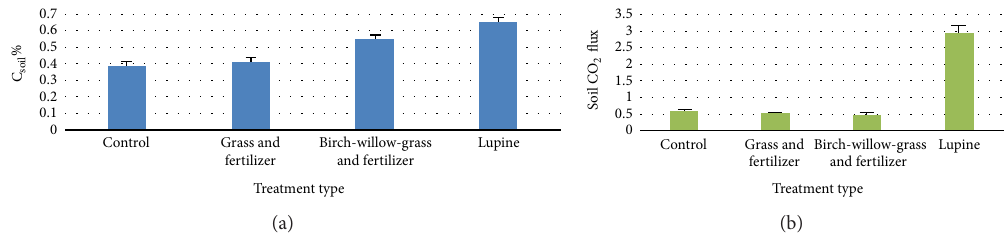
Figure 4: Summary results. (a) Mean soil carbon content for all samples (A and B layers combined shown plus one standard error) for all four treatments: 𝑁 = 50 for control and lupine plots; 𝑁 = 75 for grass and grass-birch-willow treated plots. (b) Mean soil CO 2 flux (in 𝜇 molm −2 sec −1 ). Sample size as in (a) (shown plus one standard